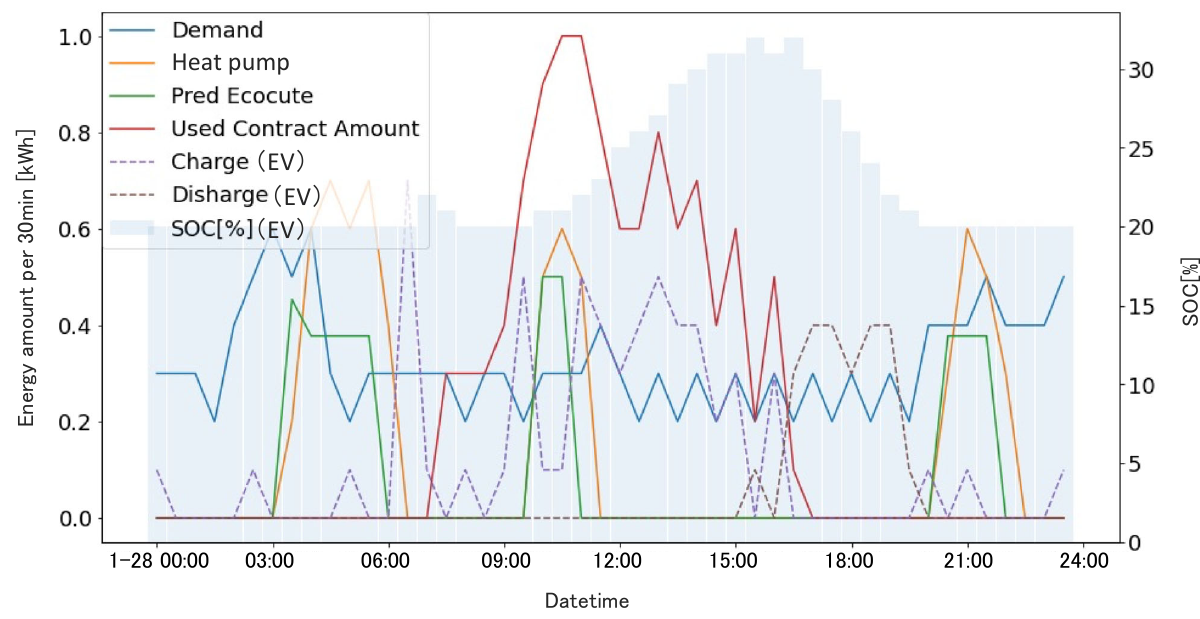
Figure 4. Electricity usage of HOME1 on one day during Phase 1 of the experiment.